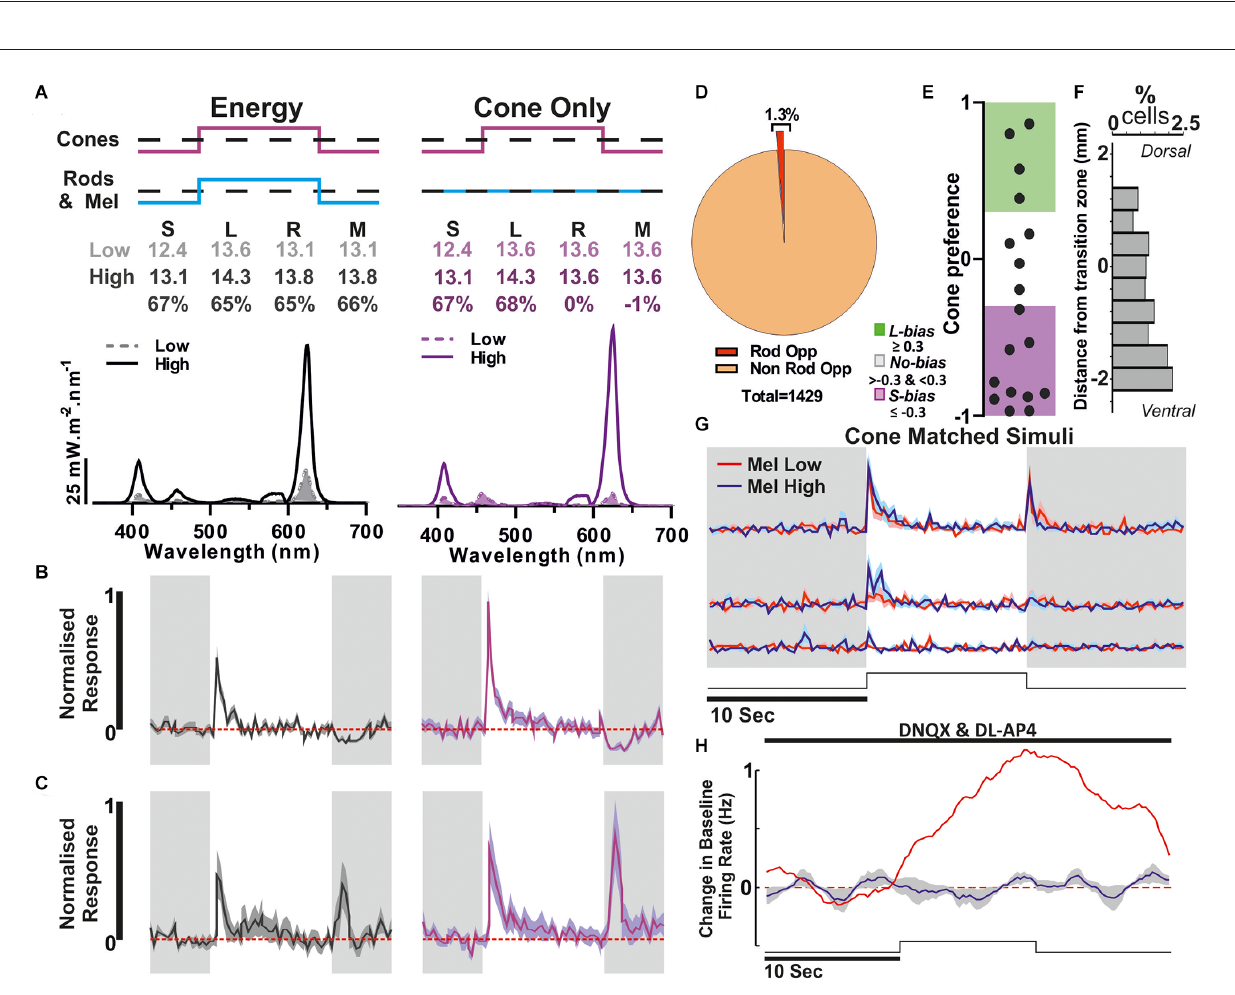
FIGURE6 Putative Rod opponency. (A) Paired light stimuli used to detect Rod opponency. Above : Relative photon absorbance (log 10 photons) and Michelson contrast for each photopigment. below spectra, dashed filled line: low, solid line: high. (B) An example unit showing evidence of rod-opponency, where responses to L+S contrast were greater than the response to equivalent contrast applied to both rods and cones. (C) Mean ± SEM of all cells with evidence of rod opponency ( n = 18/1,429). (D) Proportion of units that responded to the 67% Michelson contrast steps that were classified as rod opponent. (E) Cone preference of putative Rod Opponent cells ( n = 18). (F) Percentage of cells that are classed as rod opponent at each location. (G,H) Population data from all units displaying rod opponency. (G) Response to Mel high and Mel low steps from darkness (Mel high: blue, Mel low: red). (H) Response to a 10 s light step (Monochromatic Blue light, 90 s ISI) in the presence of synaptic blockade (spectra and irradiance as used in Figure 3 ).